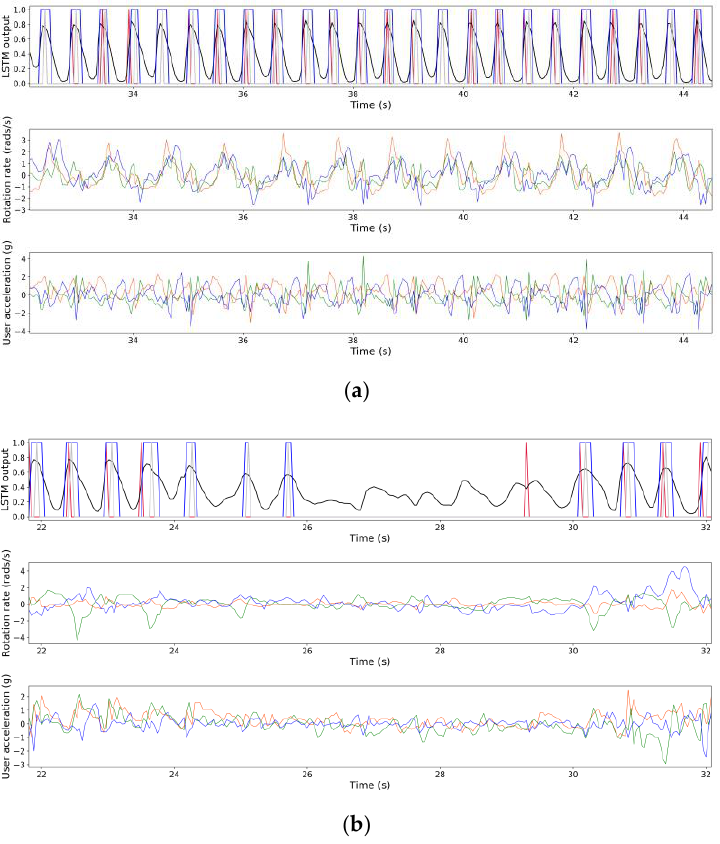
Figure 1. Examples of step detection. ( a ) Top row: the output of LSTM (black line) is thresholded, and the midpoints of the resulting positive segments (gray line) are taken as the estimated times of heel strike (ground-truth shown by red line). The LSTM takes in input the 3-axes rotation rate (middle row) and the 3-axes user acceleration (bottom row). Examples of overcounts are seen in ( b ) between 𝑡 = 24 s and 𝑡 = 26 s. An example of undercount is seen between 𝑡 = 29 s and 𝑡 = 30 s.